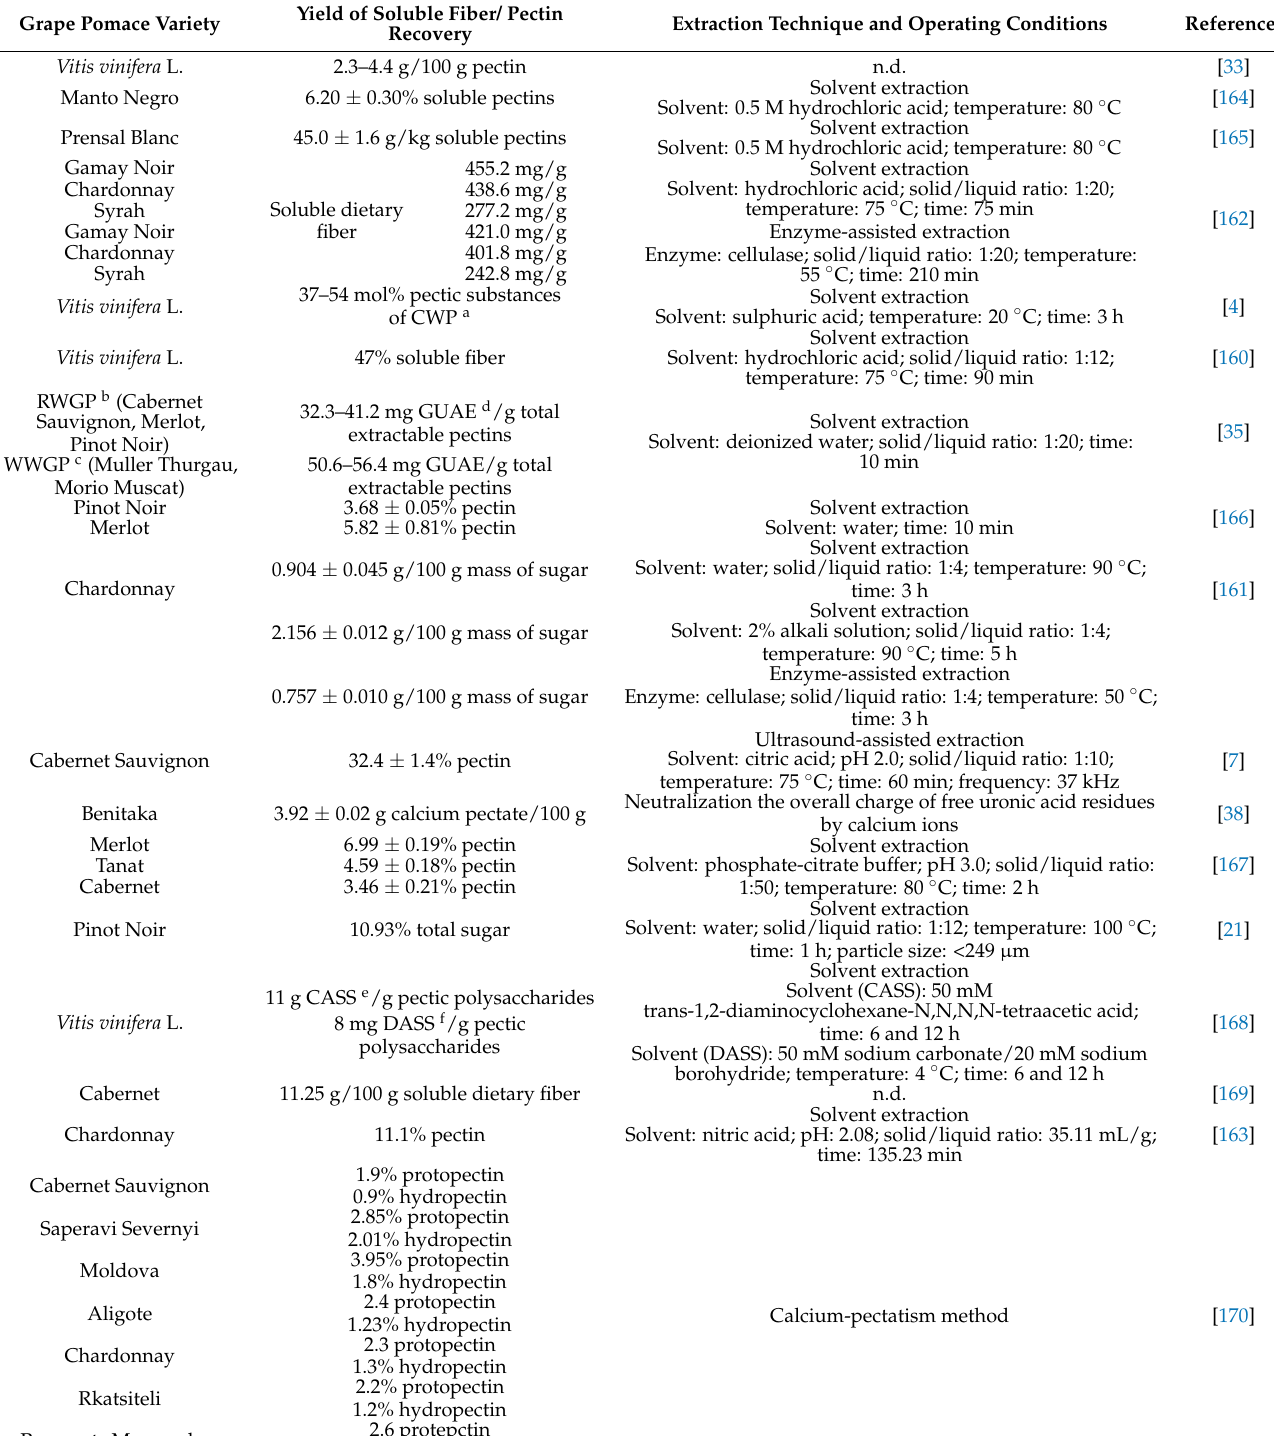
Table 4. Grape pomace soluble fiber/pectin content and extraction